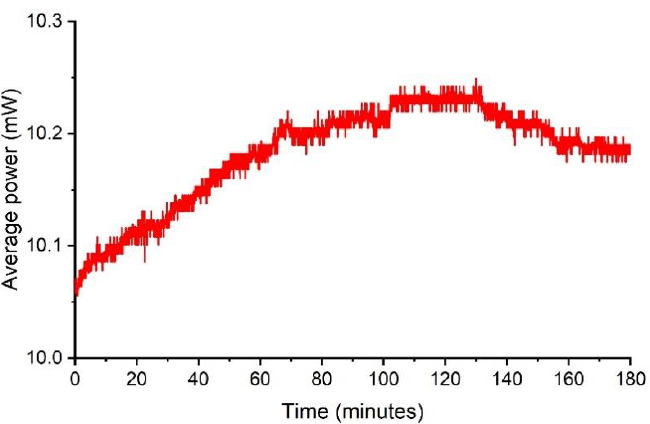
Figure 7. Single-frequency laser output power versus time.